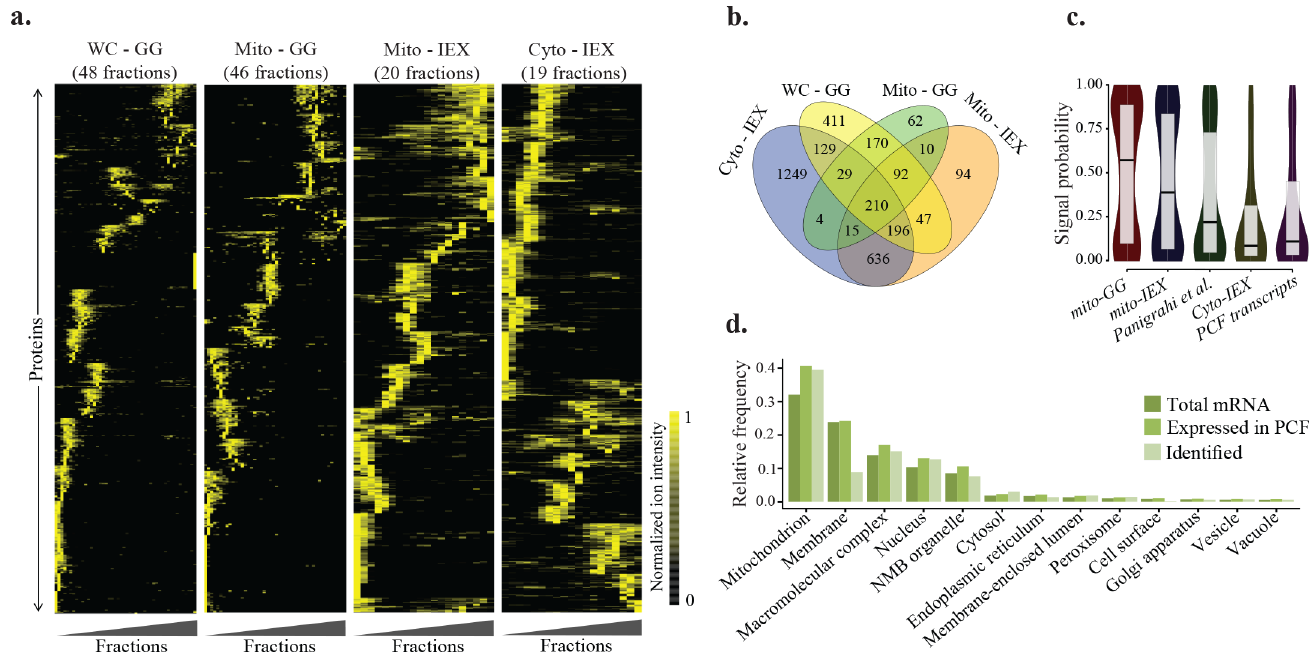
Fig 2. High resolution fractionation experiments on the procyclic stage of T . brucei . a) Hierarchical clustering of fractionation patterns for proteins identified in each of four experiments on T . brucei procyclic cells. Each row represents a protein and each column a fraction. It should be noted that the number of fractions as well as number of identified proteins varies among datasets (i.e., fractionation experiments). Moreover, datasets were analyzed independently and, therefore, the positions of proteins are not preserved in the graphs. b) Venn diagram representing proteins identified in each of four experiments. c) Comparison of the mitochondrial signal probability distribution for proteins identified in our mitochondrial and cytosolic enriched experiments with those identified by Panigrahi et al. [25] and total identified mRNAs in procyclic life stage of T . brucei [45]. The signal probability for each protein was calculated using the mitoProt web service [46]. As illustrated, the signal probability for our mitochondrial enriched samples were significantly higher (comparing to proteins identified in Panigrahi et al. [25]; p-value < 1.4E-08, Wilcoxon-Mann-Whitney rank sum test) and for the cytosolic experiment significantly lower (comparing to total procyclic transcripts; p-value < 1.4E-07, Wilcoxon-Mann-Whitney rank sum test) than that of the other two groups. d) Gene ontology – cellular component (GO-CC) analysis of all identified proteins in this study compared with the mRNAs that are expected to be expressed in the procyclic stage [45] and total predicted mRNAs in T . brucei . NMB Organelle: Non-membrane-bounded Organelle.